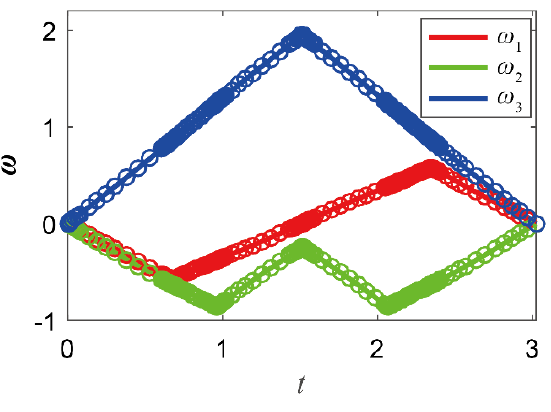
Figure 4. Nondimensional angular velocity histories and the valida- tion by propagation for Case